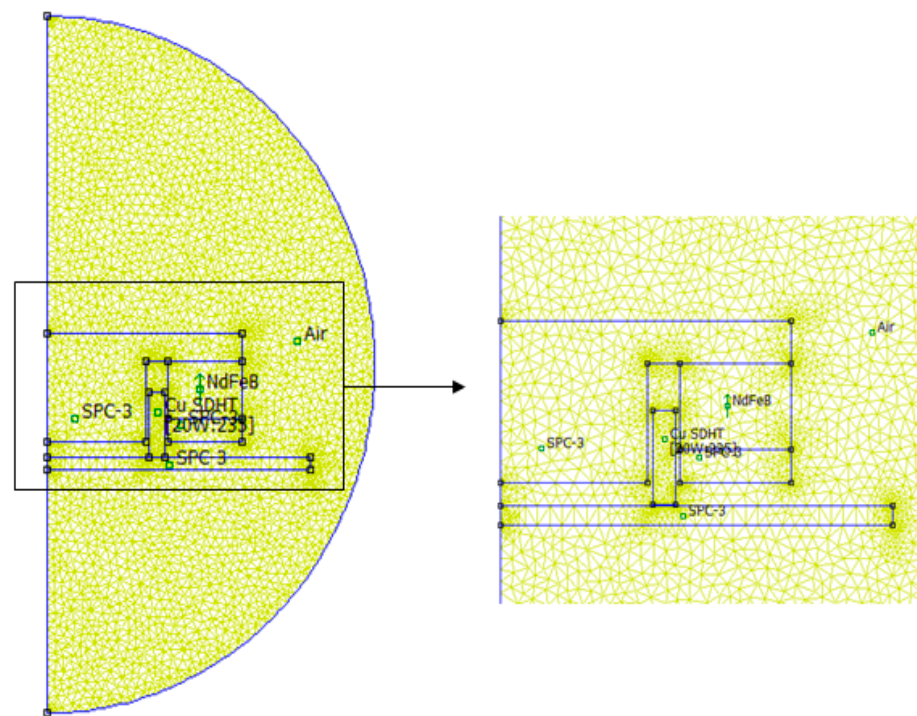
Figure 2. Model of electromagnetic field analysis from vertical magnetization structure.